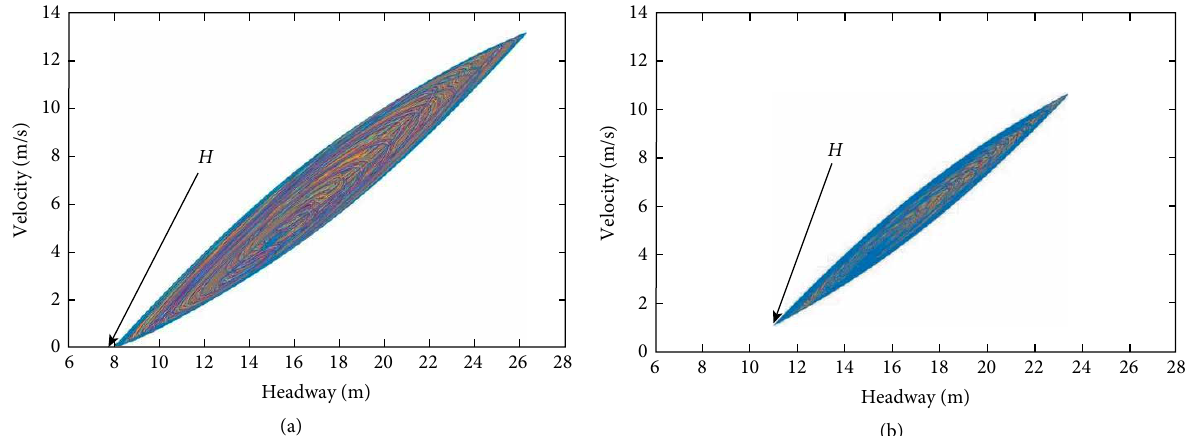
Figure 8: Hysteresis loops for FVD model and AMD model with